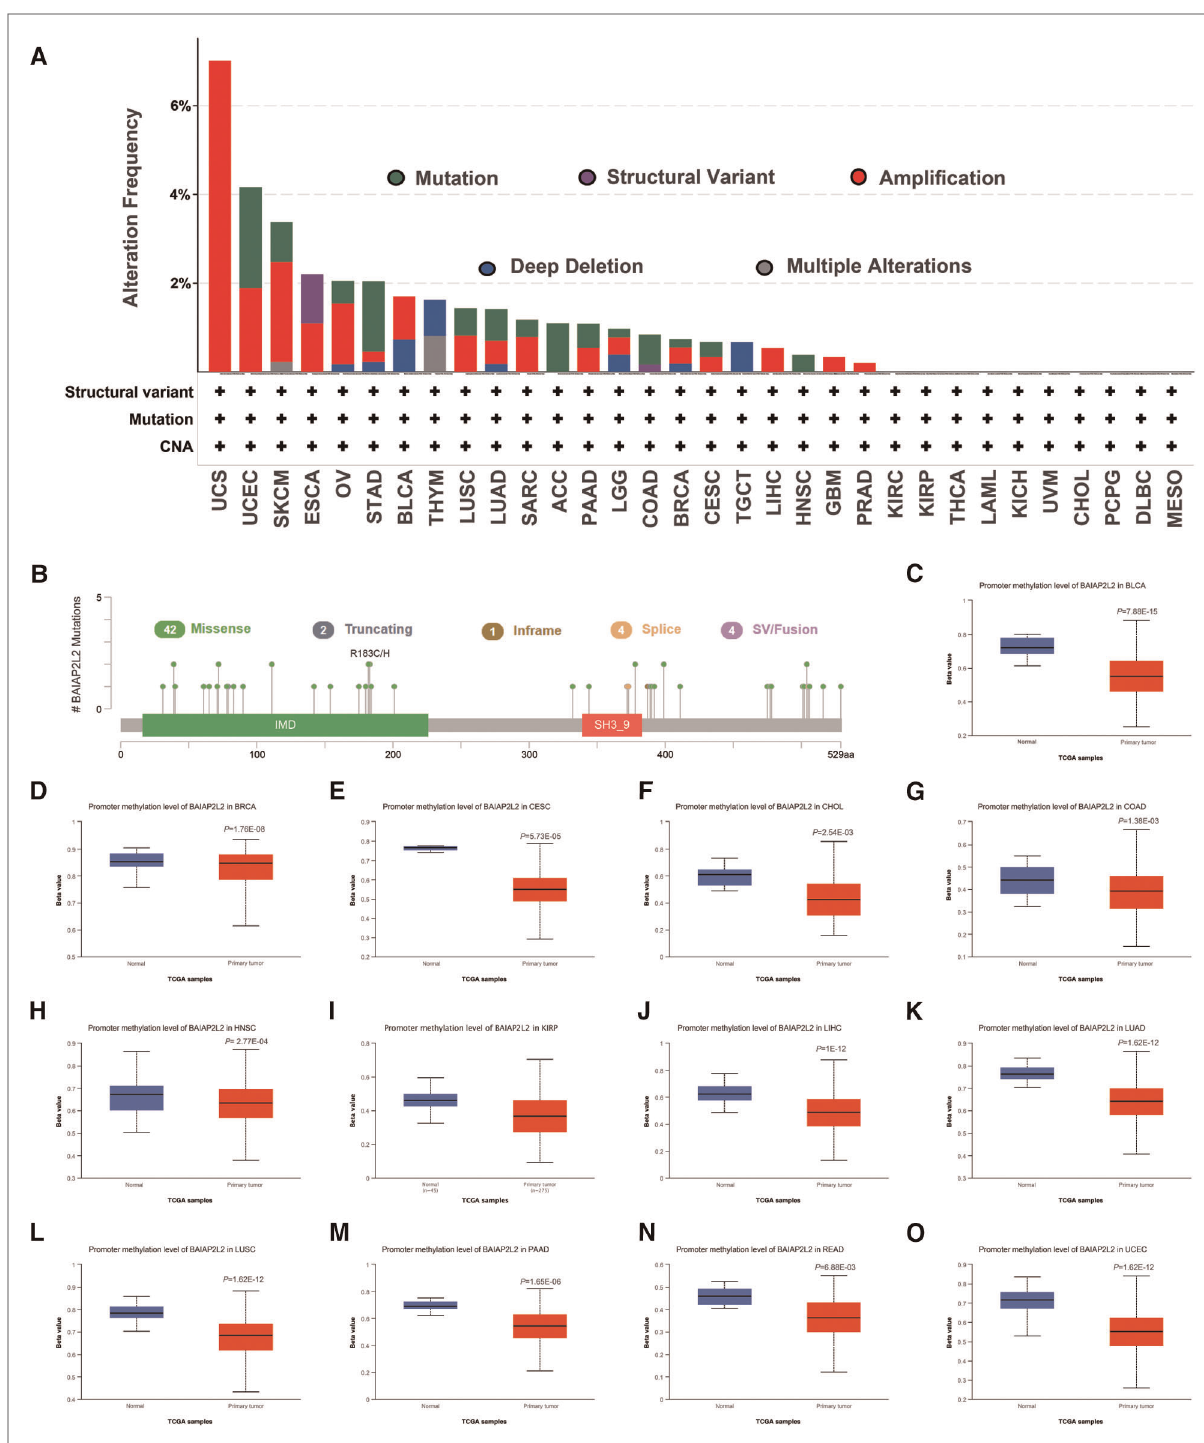
FIGURE 3 BAIAP2L2 mutated landscapes and methylation levels. ( A ) BAIAP2L2 mutation frequency in multiple TCGA pancancer studies according to the cBioPortal database. ( B ) Mutation diagram of BAIAP2L2 in different cancer types across protein domains. ( C – O ) BAIAP2L2 methylation levels were determined by UALCAN, and different beta value cutoffs have been considered to indicate hypermethylation [beta value: 0.7 – 0.5] or hypomethylation [beta value: 0.3 –